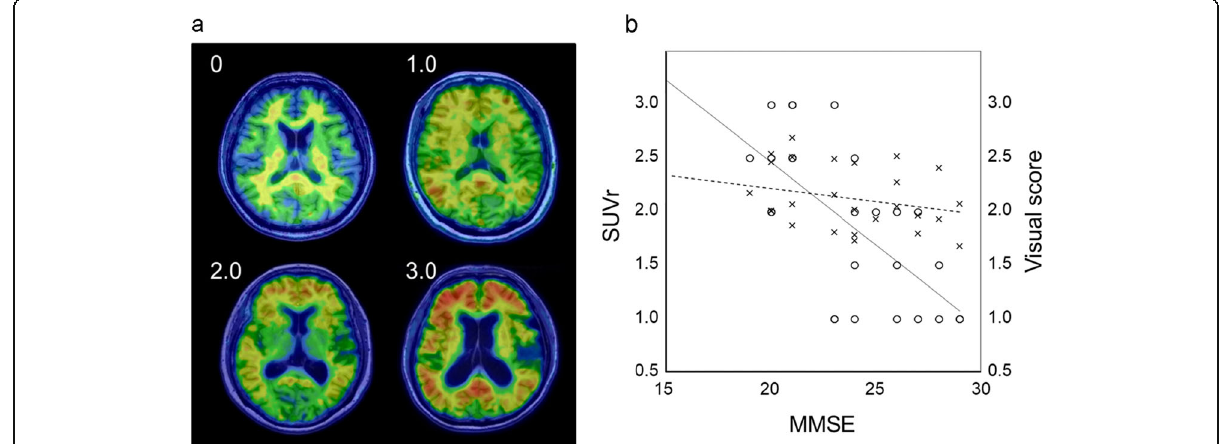
Fig. 4 Visual scores for assessment of cortical [ 11 C]PiB deposition ( a ) defined as 0, negative; 1, slightly positive; 2, moderate; and 3: severe accumulation. The graph shows correlation between MMSE scores and [ 11 C]PiB accumulation intensity determined by SUVr (crossing) and visual scores (open circle) ( b ). The plots of MMSE vs. SUVr did not show significant correlation (dotted line, r = 0.30, P > 0.05), while those of MMSE vs. visual score showed a significant correlation (solid line, r = 0.71, P <